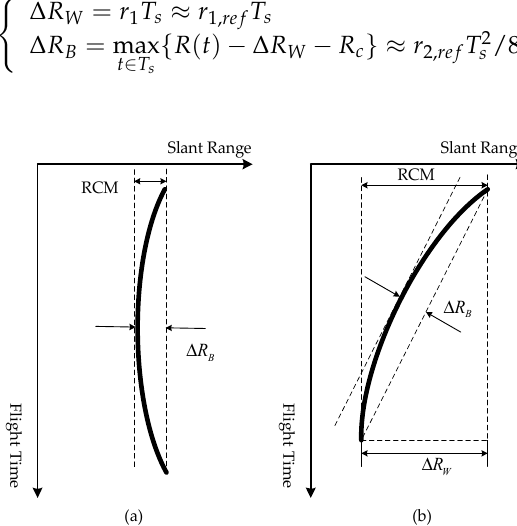
Figure 3. Range cell migration (RCM) of GEO SAR: ( a ) Broadside looking mode; ( b ) squint looking mode.